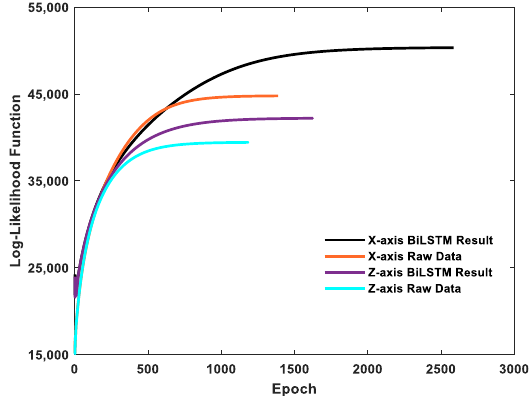
Table 8. Kalman filter parameters of all measurements.